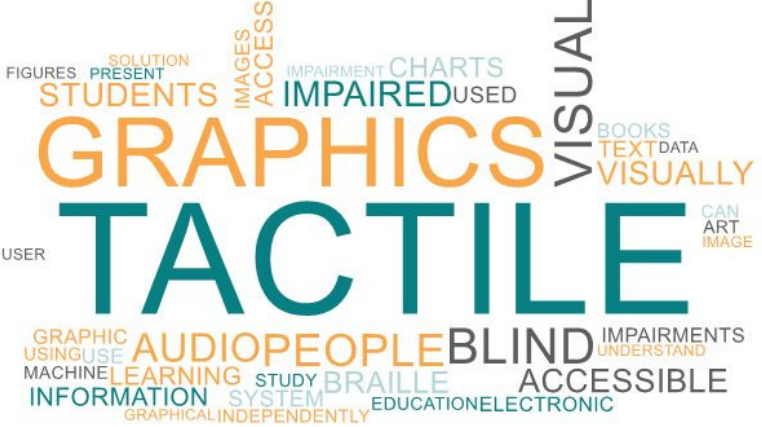
Figure 10. The most frequent terms in tactile graphics generation for the BVI people based on our selected primary studies. Max word limit is 40.